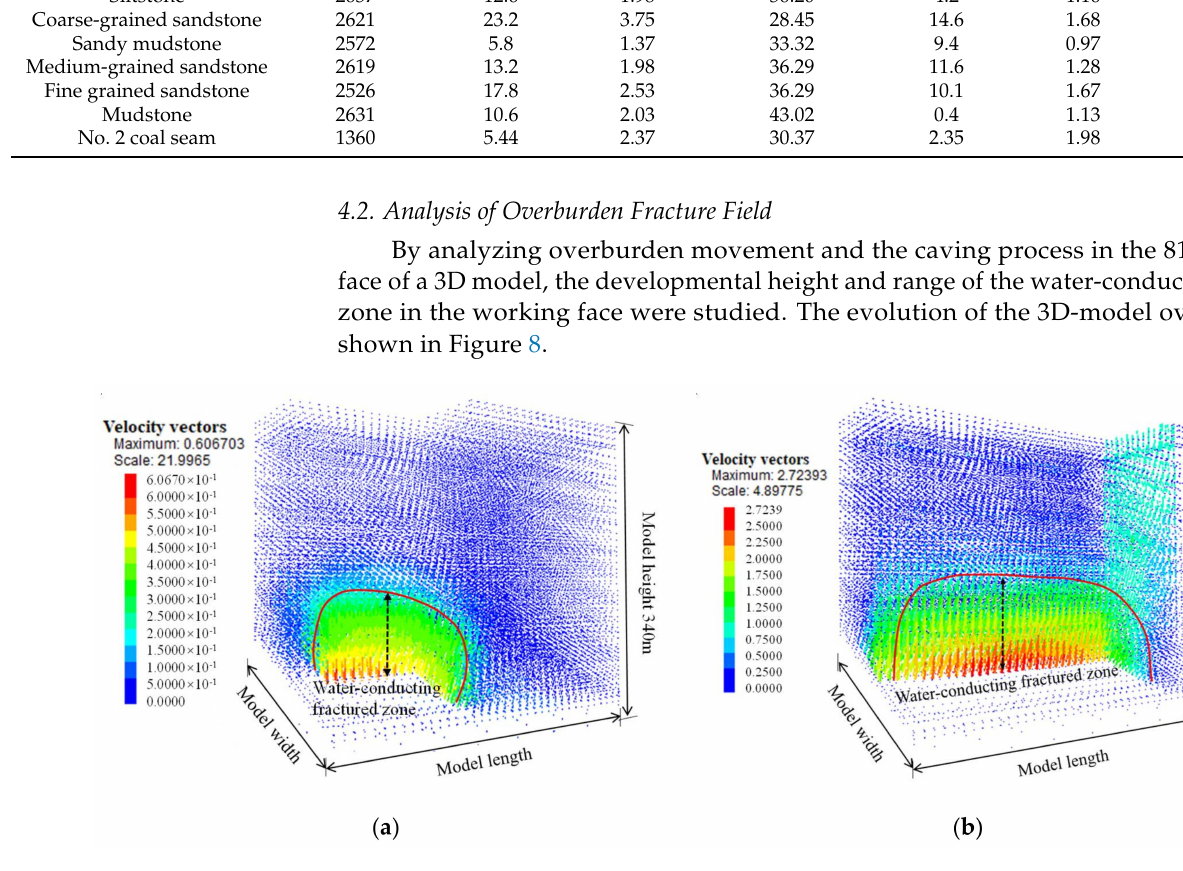
Figure 8. Evolution of three-dimensional model overburden: ( a ) working face mining at 167 m; ( b ) end of mining